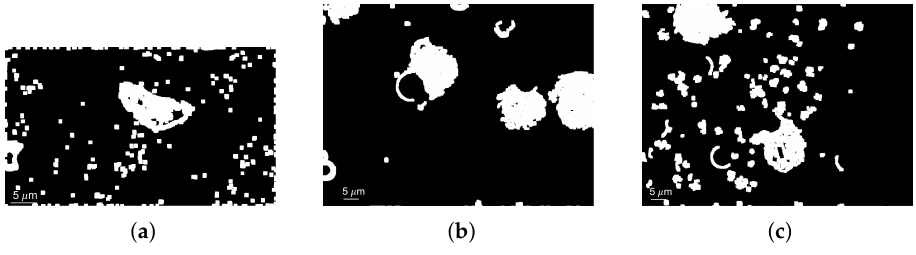
( x , y ) ; ( b ) I sw ( x , y ) ; ( c ) I sm ( x , y ) jd jd jd